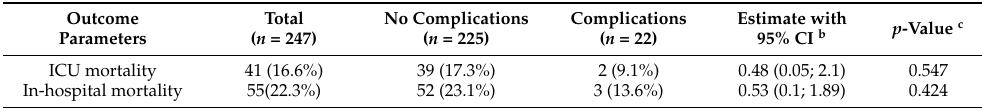
Table 4. Mortality a of study patients ( n =